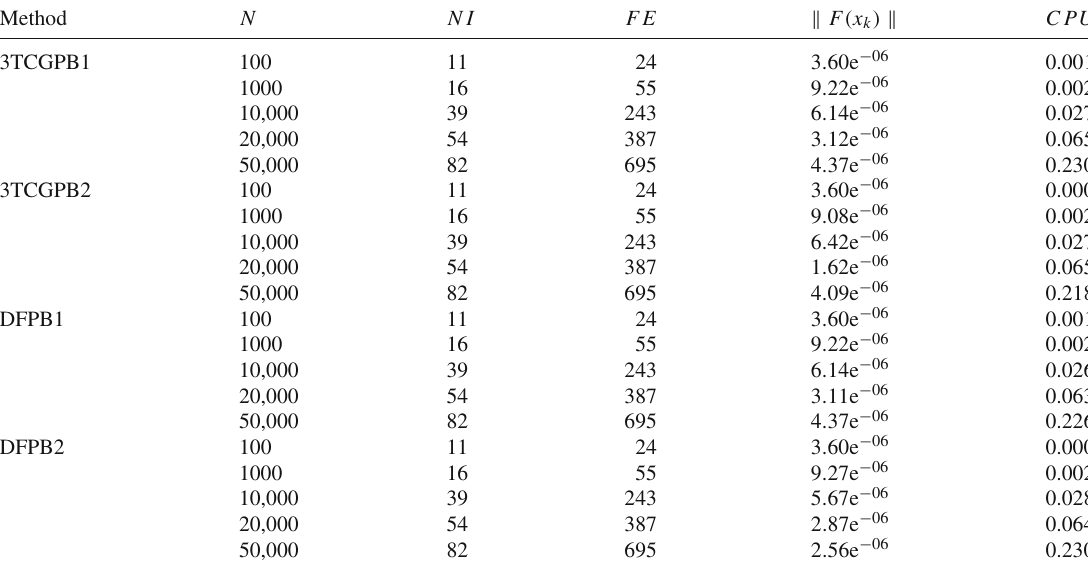
Table 3 Numerical results of Problem 4.3